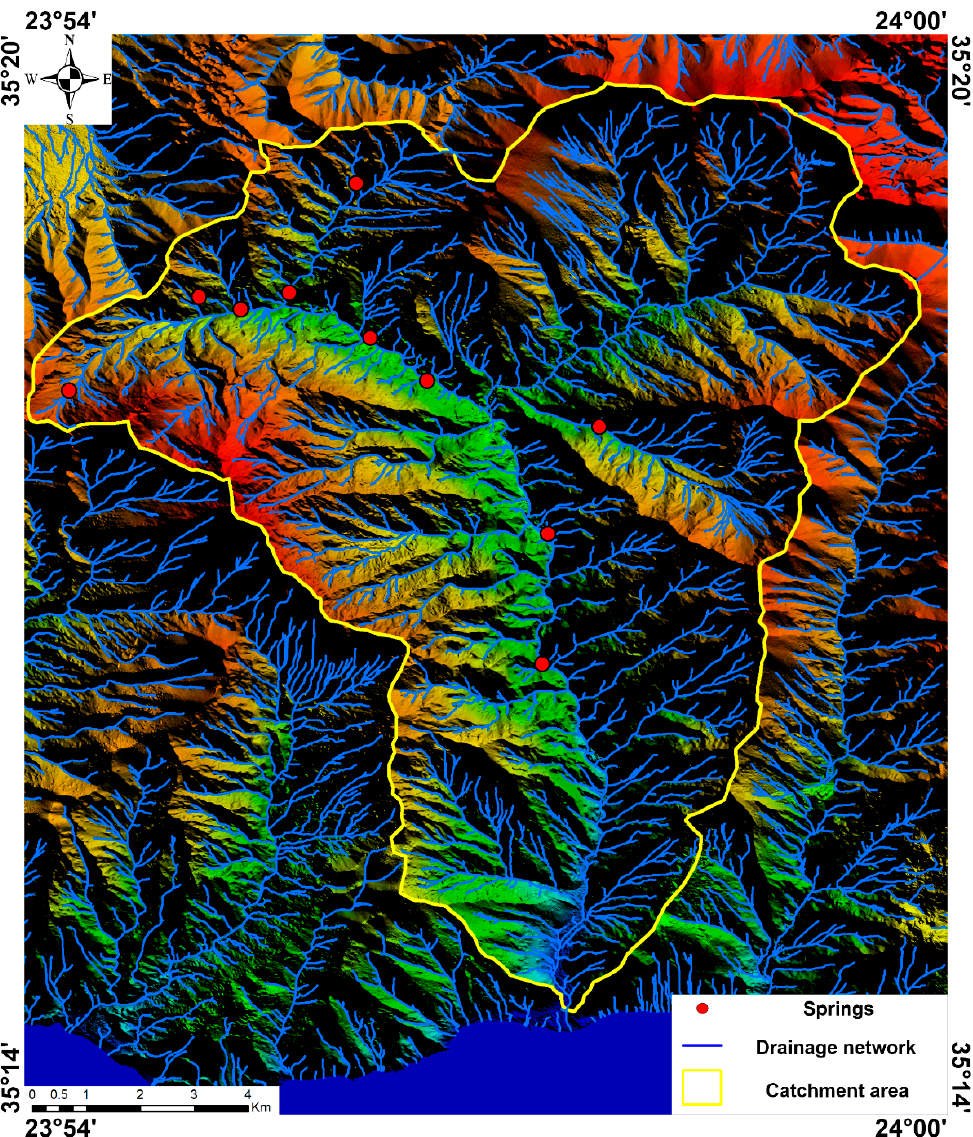
Figure 7. Catchment area of Samaria River, including the drainage network and springs outlets.